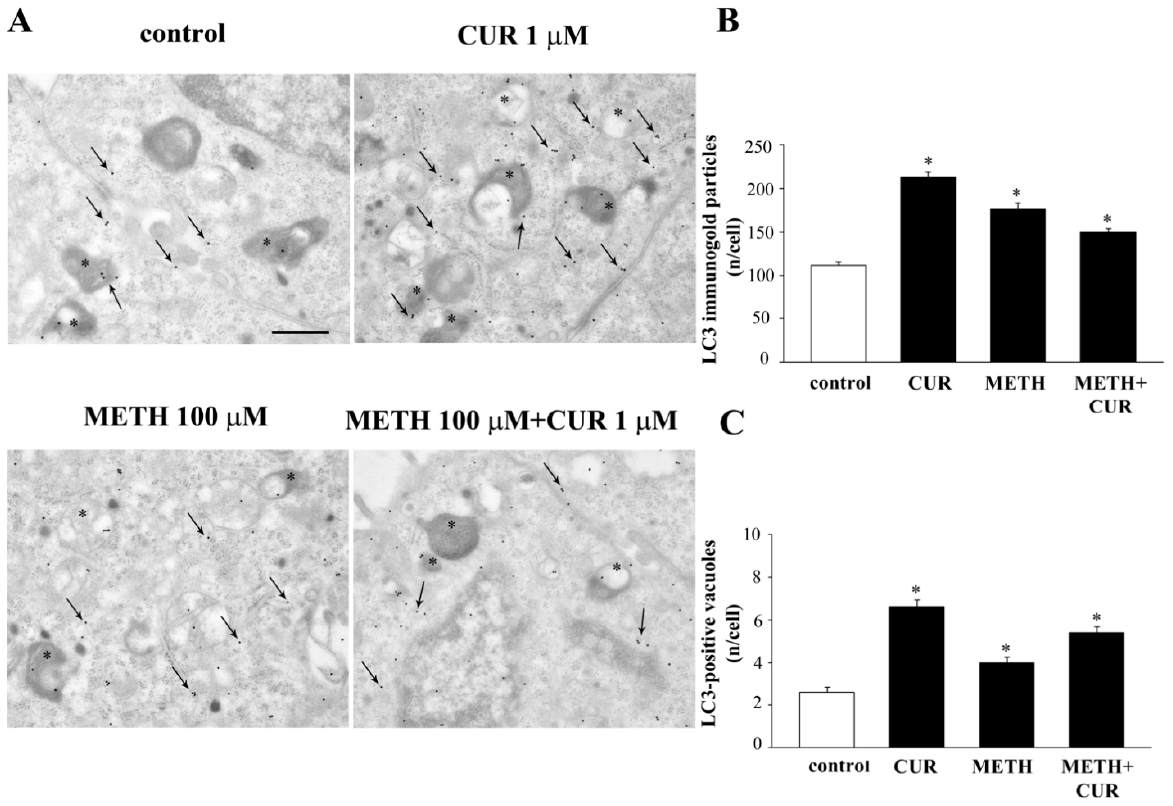
Figure 17. CUR increases the amount of LC3-positive vacuoles. ( A ) Representative TEM micrographs showing LC3-posi- tive vacuoles (*) Arrows point to LC3 immuno-gold particles widespread in the cytosol. Graphs report the number of LC3-immunogold particles ( B ) and LC3-positive vacuoles ( C ) per cell. * p < 0.05 compared with control. Scale bar = 0.3 μ m.